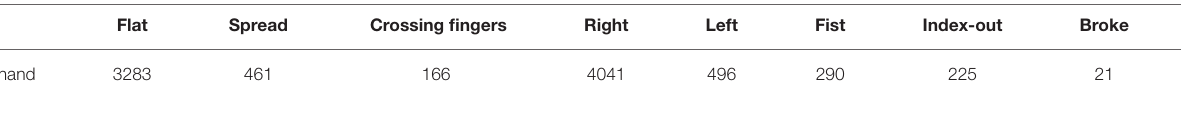
TABLE 3 | Emblem—frequency of items from the hand